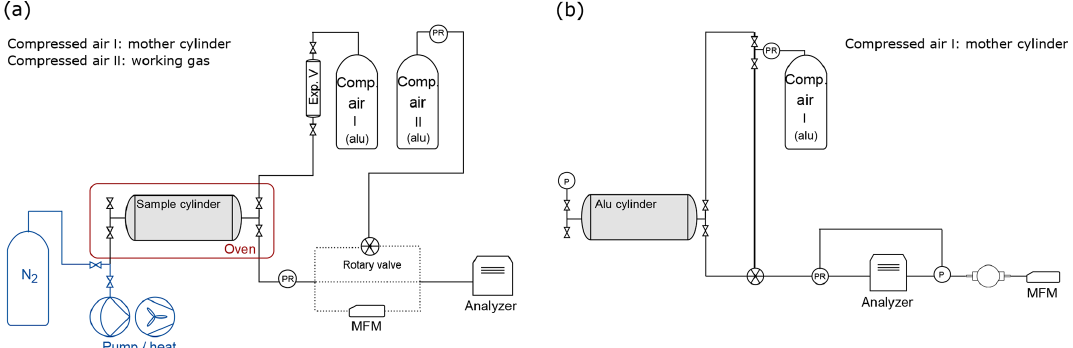
Figure 1. Measurement schemes: (a) CRDS analyzer. The sample cylinder is filled by expansion from the mother cylinder and placed in the climate cabinet (red box) for the temperature experiments. Dotted lines show the three different pathways between the outlet of the cylinder and the inlet of the analyzer. During temperature experiments, sample gas flows through the rotary valve, and during several experiments (Table 1h) sample gas flows through mass flow meter (MFM) to monitor flow. For all remaining experiments, the sample gas is directed to the analyzer with electropolished stainless steel tubing. The equipment used for the cleaning procedure applied in between experiments in Table 1e is shown in blue. (b) QCLAS system. The sample cylinder is filled through the pressure regulator. The inflow to the analyzer is switched between the mother and sample cylinder through the rotary valve. The loop around the analyzer shows the pressure regulation (see Sect. 2.3 for a detailed description). After the turbomolecular pump, a MFM is placed to monitor outflow.